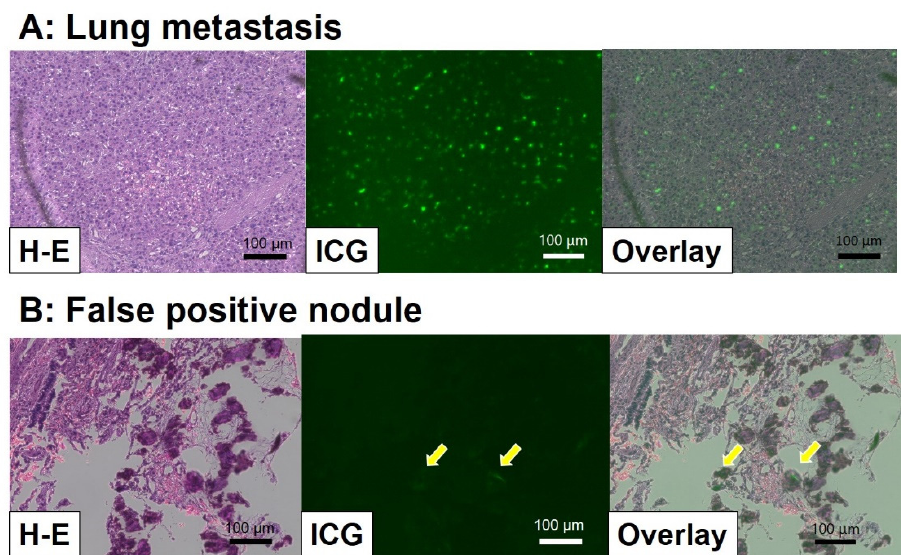
Figure 5. Histological examination via infrared fluorescence microscopy. ( A ) Lung metastasis: strong ICG signals were detectable at the tumor cells. ( B ) False positive nodule: in this lesion, weak and sticky positive signals were detected, as indicated by asterisks. These cells were considered to be